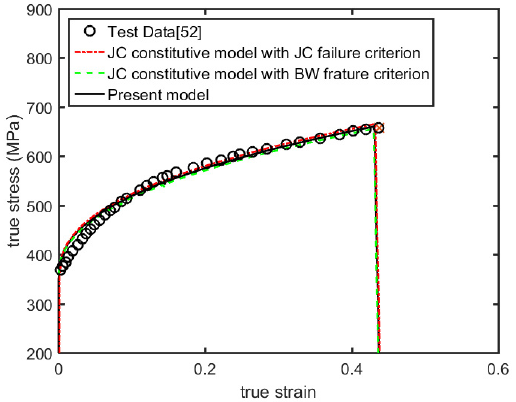
Figure 17. Comparison between the model predictions and the test data for true stress-true strain curve for 2024-T351 aluminum alloy smooth round bar tension test.